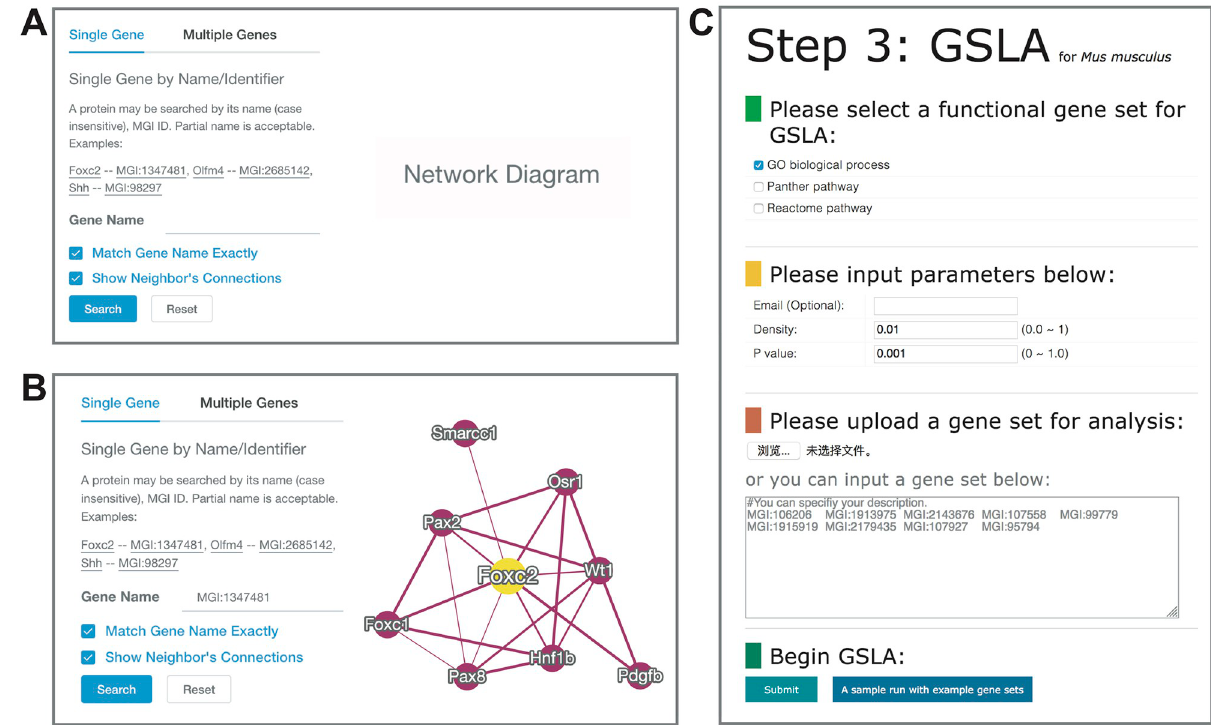
Fig 3. MID website. (A) Single gene search and multiple gene search interface. (B) Search result page. The functional associations between the query genes are illustrated in a graphical view. Right clicking on an interaction in the diagram will show its details. (C) The gene set linkage analysis webtool, GSLA interface. GSLA prefers to use MGI ID because the internal sever works only with MGI ID, it will map other ID systems (MGI ID, gene name, UniProt ID, Ensembl gene ID, Ensembl protein ID, and NCBI Entrez ID) to MGI IDs.